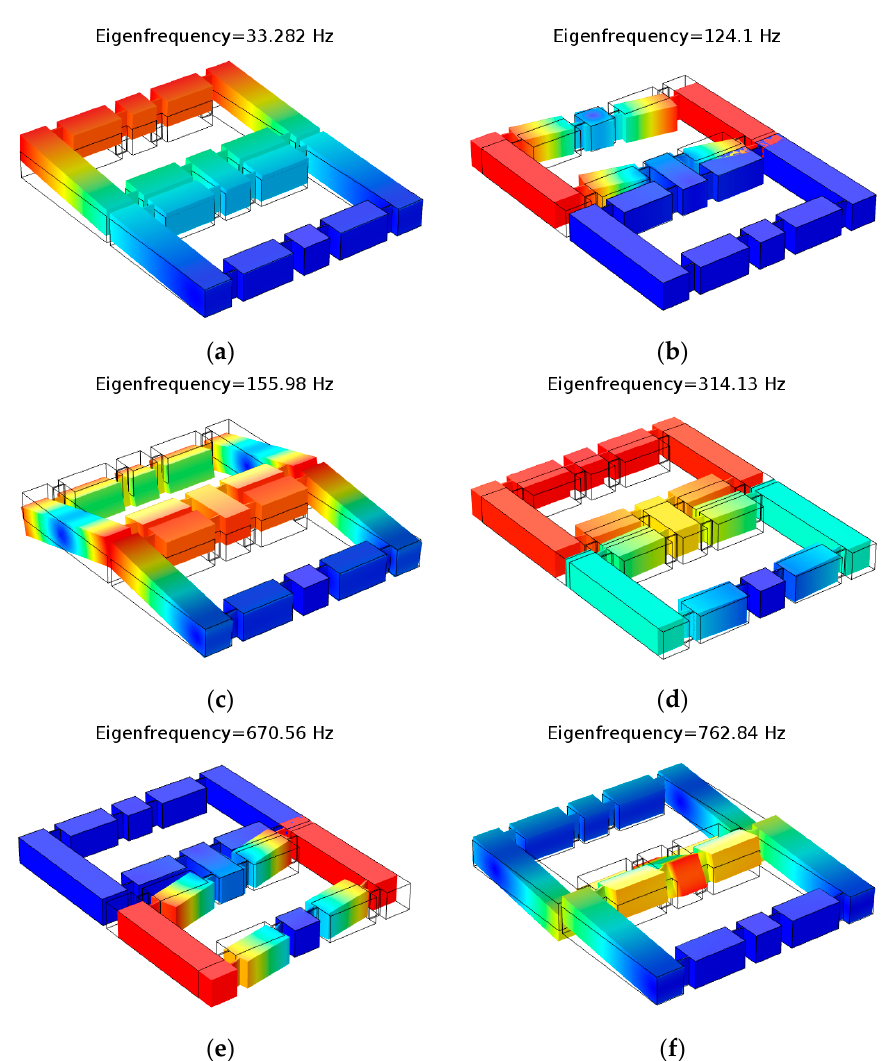
Figure 15. First six mode shapes. ( a ) first order mode shape, ( b ) second order mode shape, ( c ) third order mode shape, ( d ) fourth order mode shape, ( e ) fifth order mode shape, ( f ) sixth order mode shape.